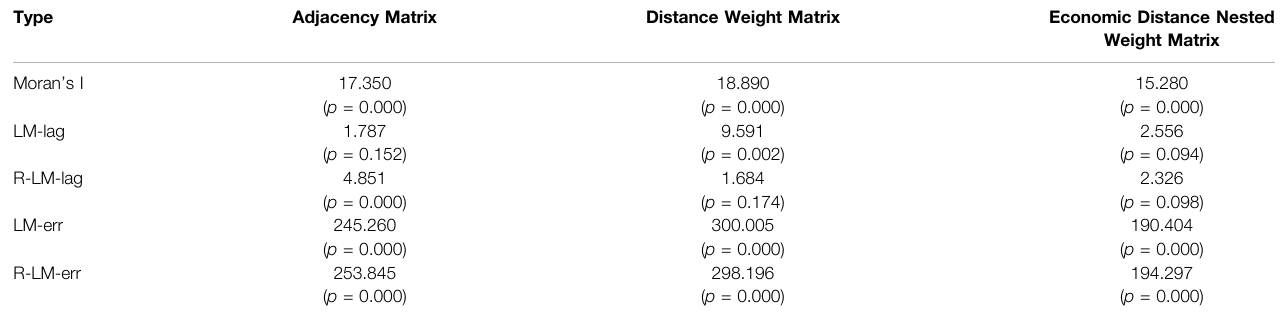
TABLE 3 | LM test results under the three weight matrices.